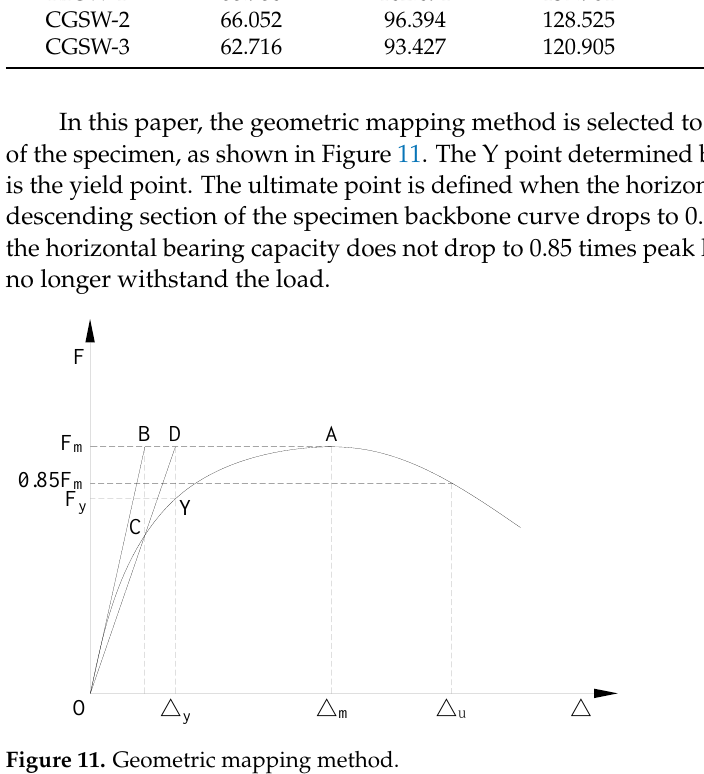
Table 6. Characteristic point bearing capacity of the specimens.